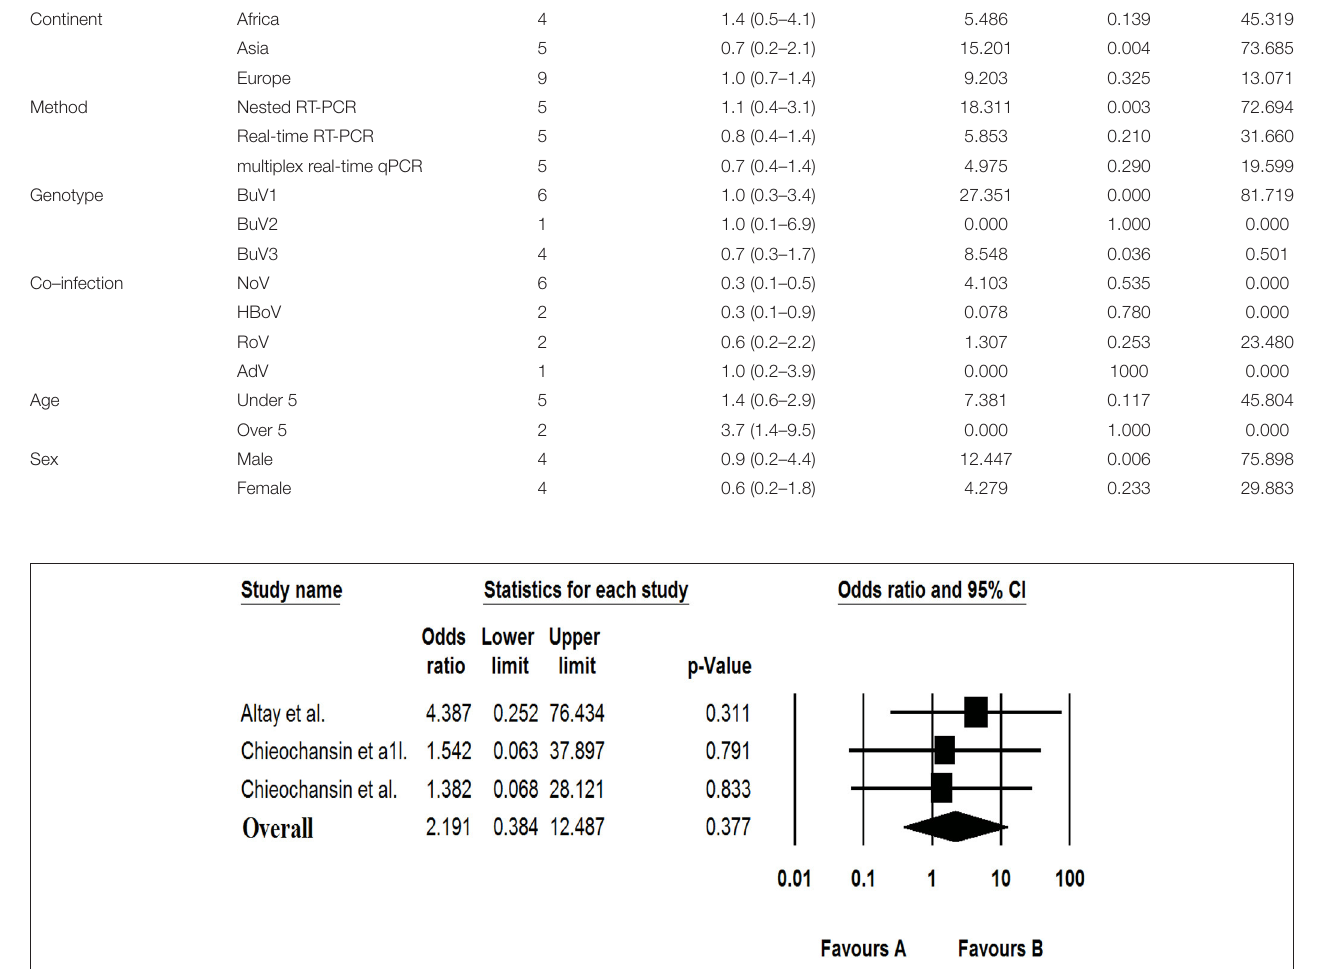
seen in America (4.2%, 95% CI, 2.6–6.6%), whereas Europe (0.2%, 95% CI, 0.1–0.7%) observed the lowest